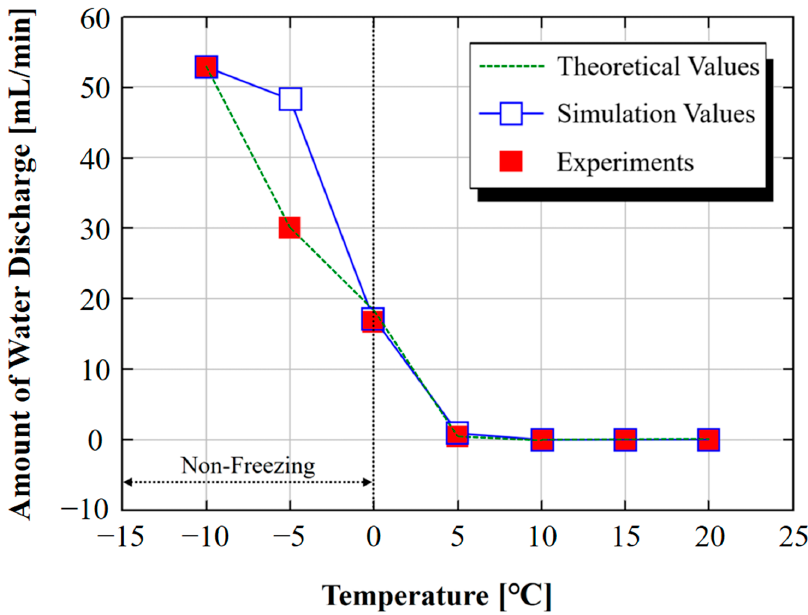
Figure 12. Comparison of the result data according to water discharge measurement methods.